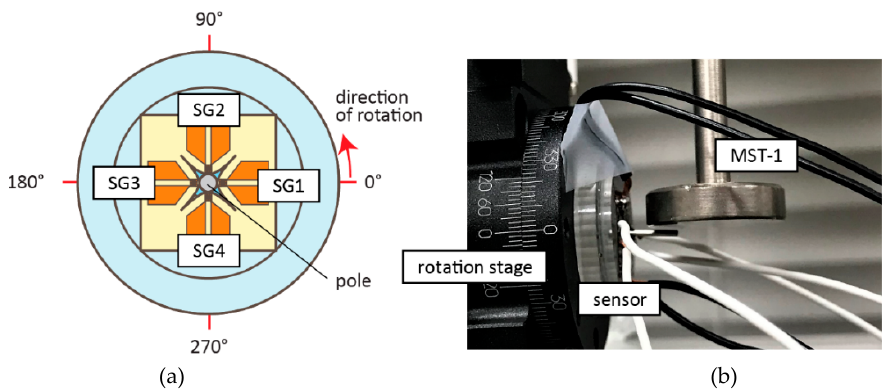
Figure 6. The experiment procedures. ( a ) Definition of the angle at which the load was applied. ( b ) The device was set on a rotation stage and the load applied to the sides of the device with micro strength evaluation testing machine (MST-I). The direction of rotation from 0 ° to 360 ° during the experiment, with load applied every 15 ° .